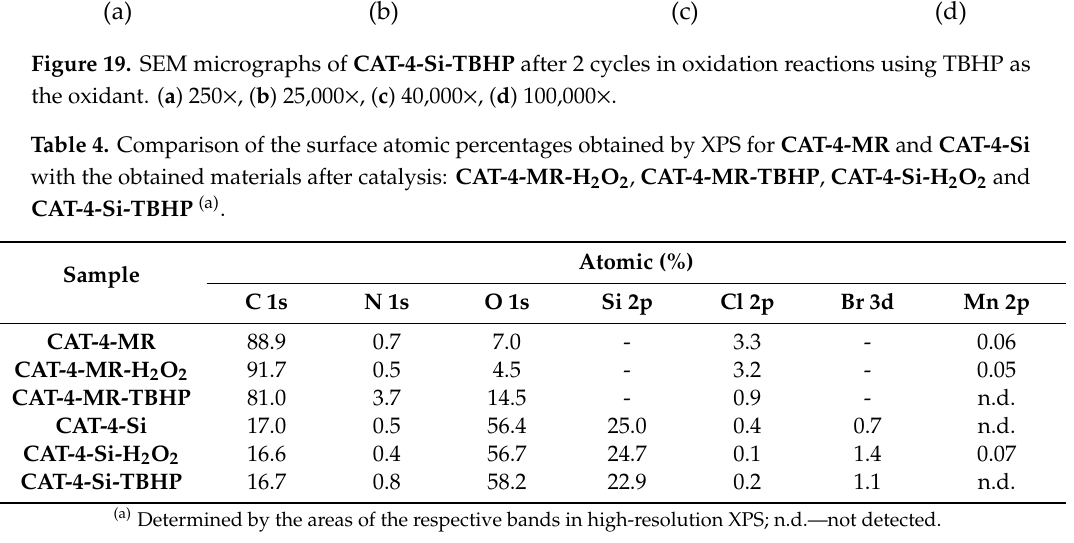
Figure 19. SEM micrographs of CAT-4-Si-TBHP after 2 cycles in oxidation reactions using TBHP as